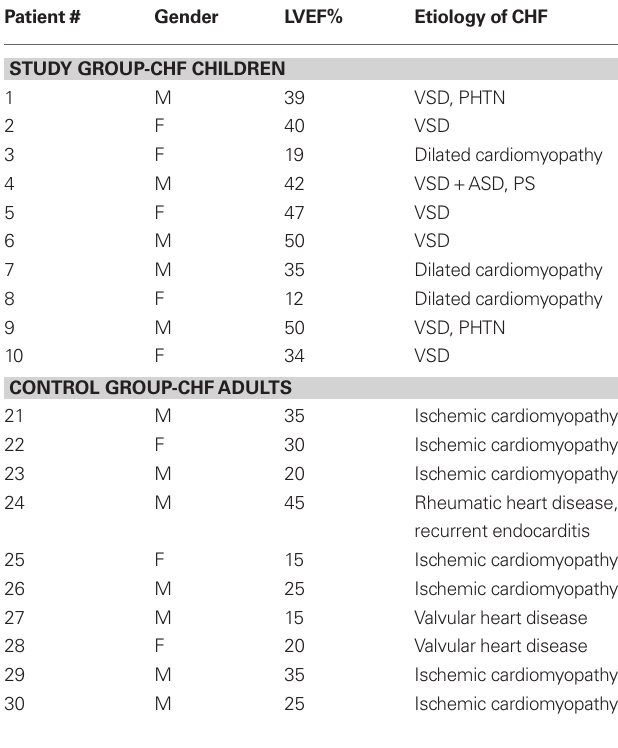
Table 2 | Characteristic of the CHF patients according to their group.